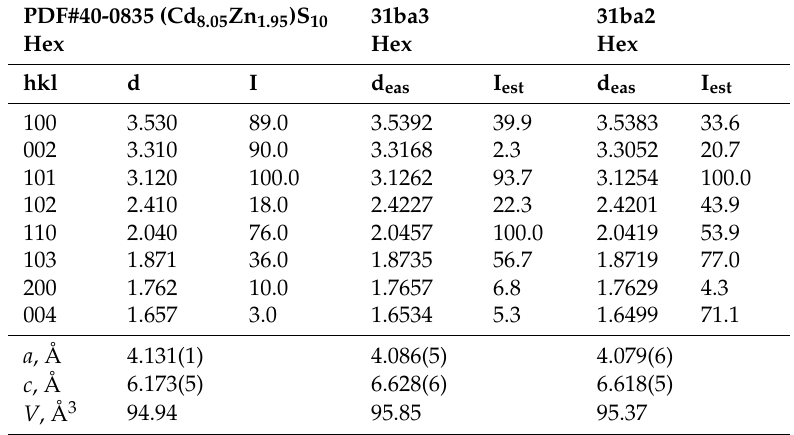
Table 4. X-ray diffraction data for zinc greenockite in comparison with ICCD data.